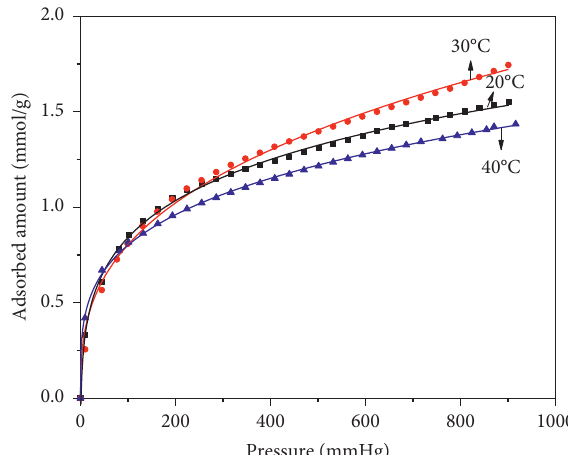
Figure 12: Carbon monoxide adsorption isotherms of 3CuCl/ diatomite at different temperatures.